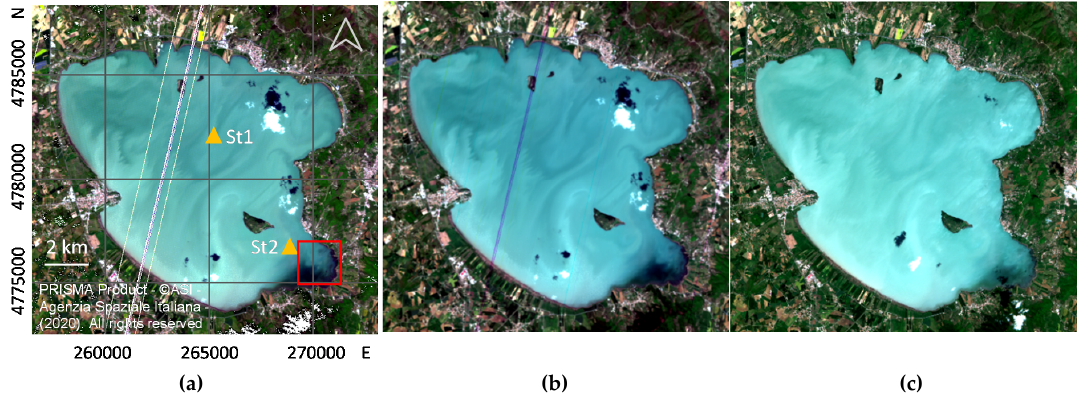
Figure 1. True color images of Lake Trasimeno ( a ) PRecursore IperSpettrale della Missione Applicativa (PRISMA) (641.55 nm, 546.66 nm, 471.12, nm), ( b ) PRISMA resampled to Sentinel-2B (664.9 nm, 559 nm, 492.1 nm), and ( c ) Sentinel-2B (664.9 nm, 559 nm, 492.1 nm) acquired on 23 April 2020. The in-situ stations (St1, St2) are located on the left image. The open bay colonized by aquatic vegetation is highlighted by a red box [9].